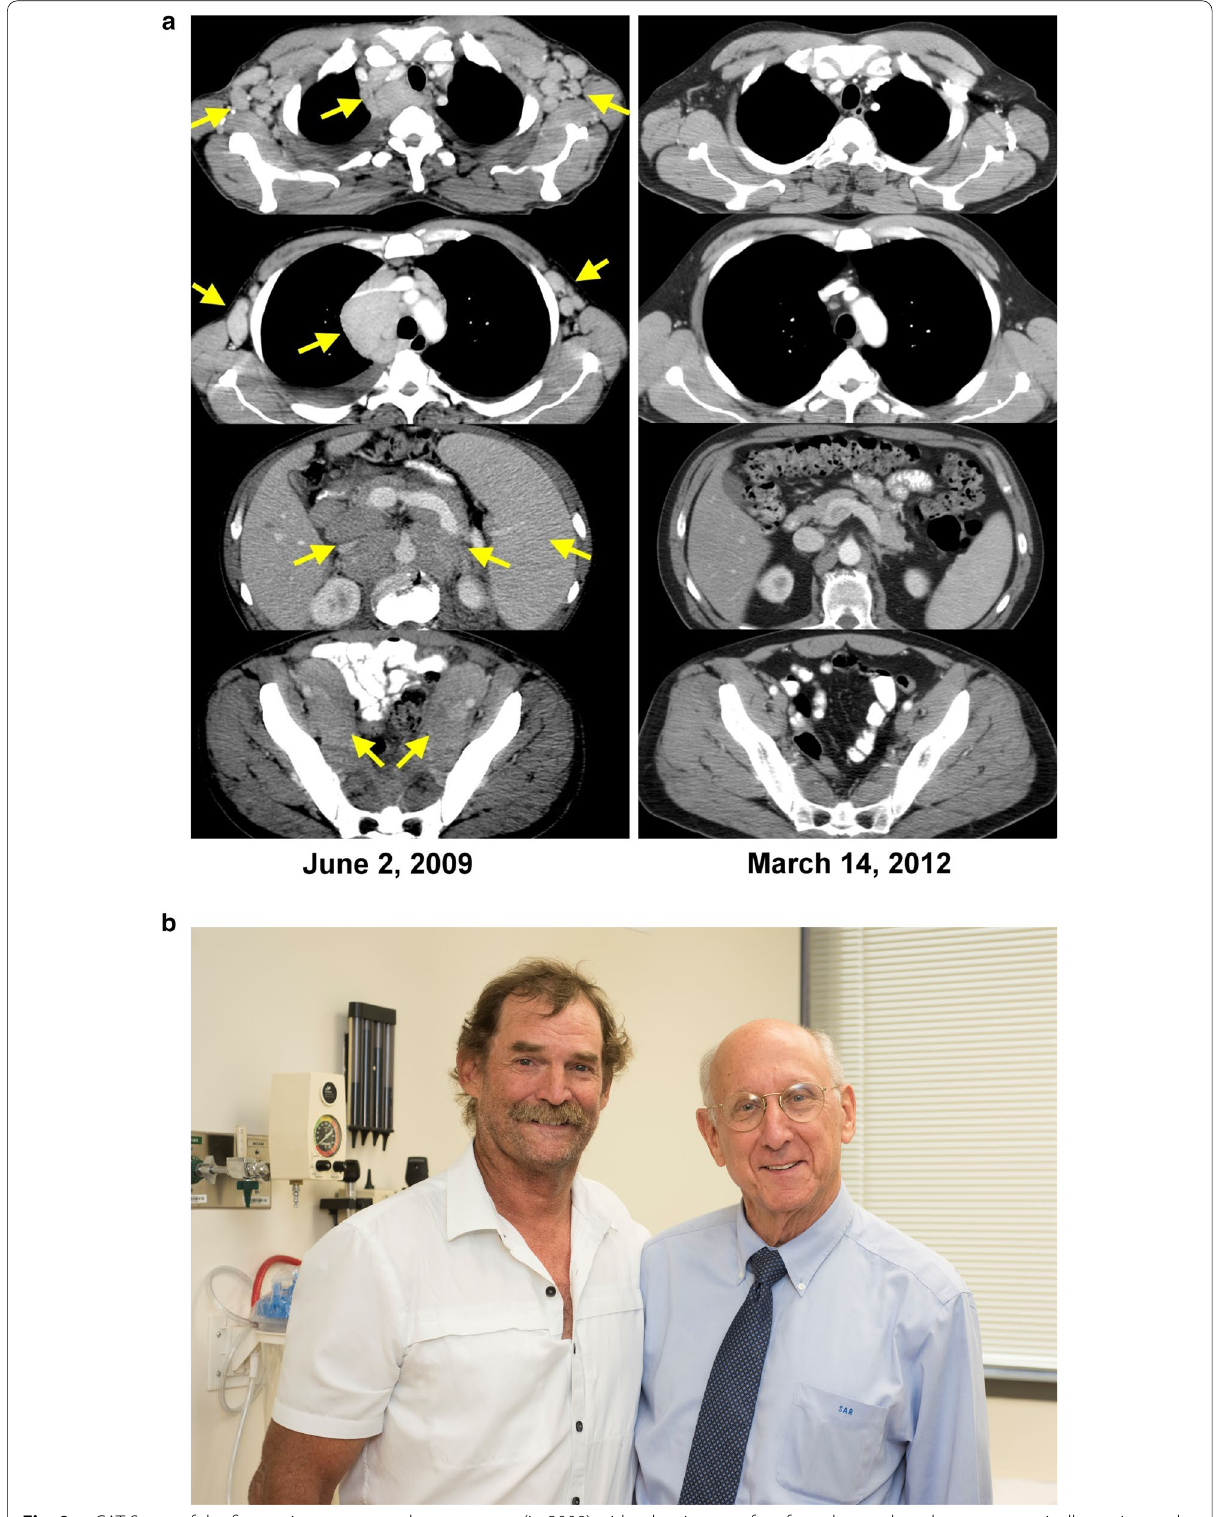
Fig. 9 a CAT Scans of the first patient to respond to treatment (in 2009) with adoptive transfer of autologous lymphocytes genetically engineered to express a chimeric antigen receptor targeting CD19 (left, lymphoma burden shown with arrows); right, complete cancer regression now ongoing over 10 years later. b In clinic with the first patient 10 years after